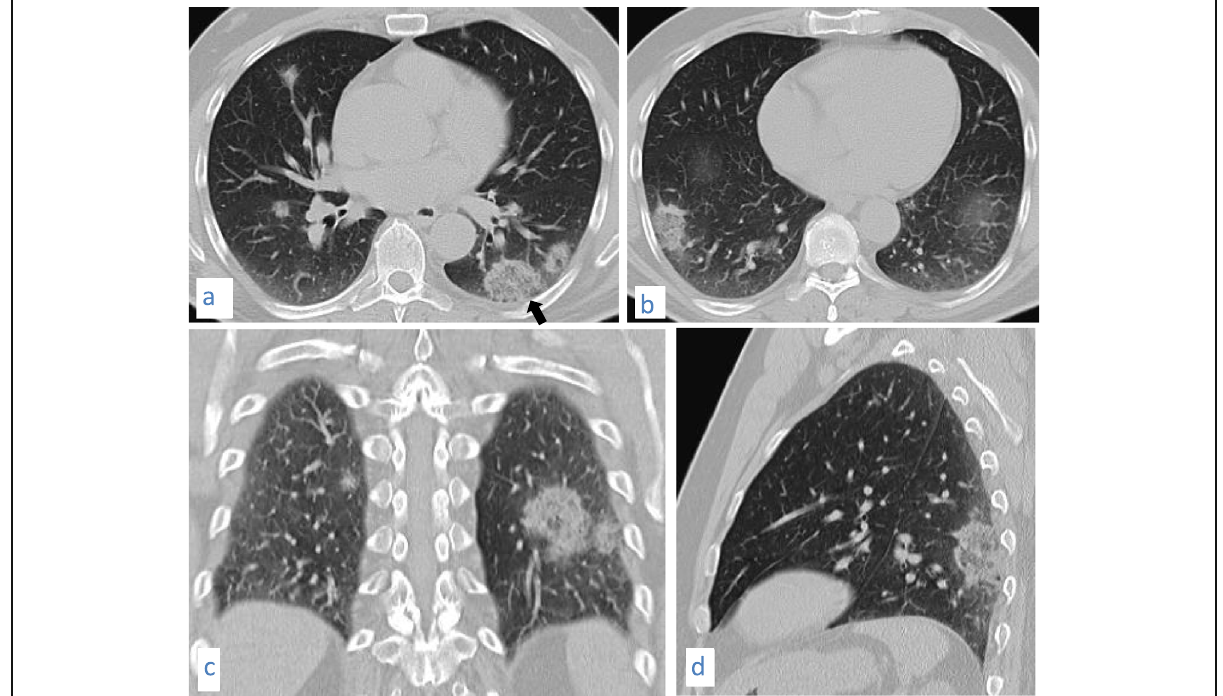
Fig. 18 A 53-year-old male patient with COVID-19. CT chest axial images ( a ) and ( b ), coronal image ( c ), and sagittal image ( d ) show subpleural ground glass opacities with vascular thickening, nodules and masses some show “ reversed halo ” sign